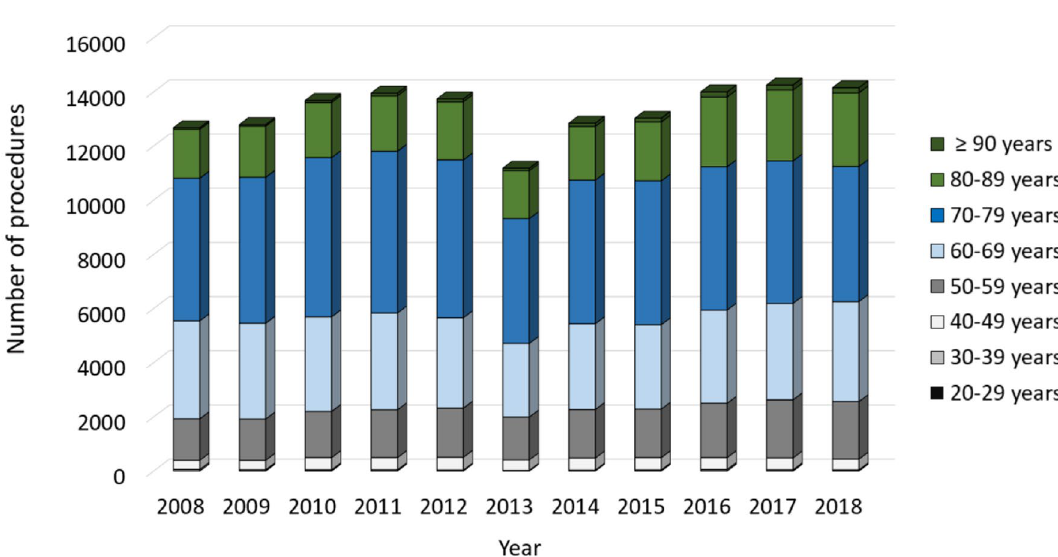
Figure 2. Performed revision knee arthroplasty procedures from 2008 through 2018 divided by gender.